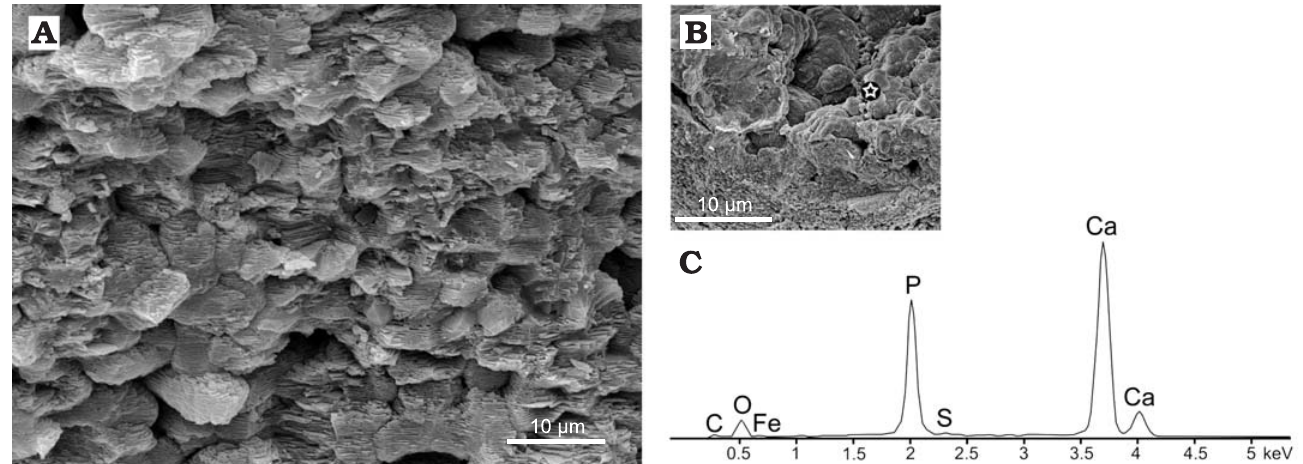
Fig. 5. Craspeditid ammonite Kachpurites fulgens (Trautschold, 1861) from the Late Volgian, Kachpurites fulgens Zone, Moscow region, Eganovo locality, Central Russia; shell structure and chemical composition of the filling of pits, MSU 118/1. A , B . Aragonite layer of the shell. C . EDS (Energy Dispersive X-ray Spectroscopy) analysis of the brown mineral in the pit on the surface of specimen (asterisk in